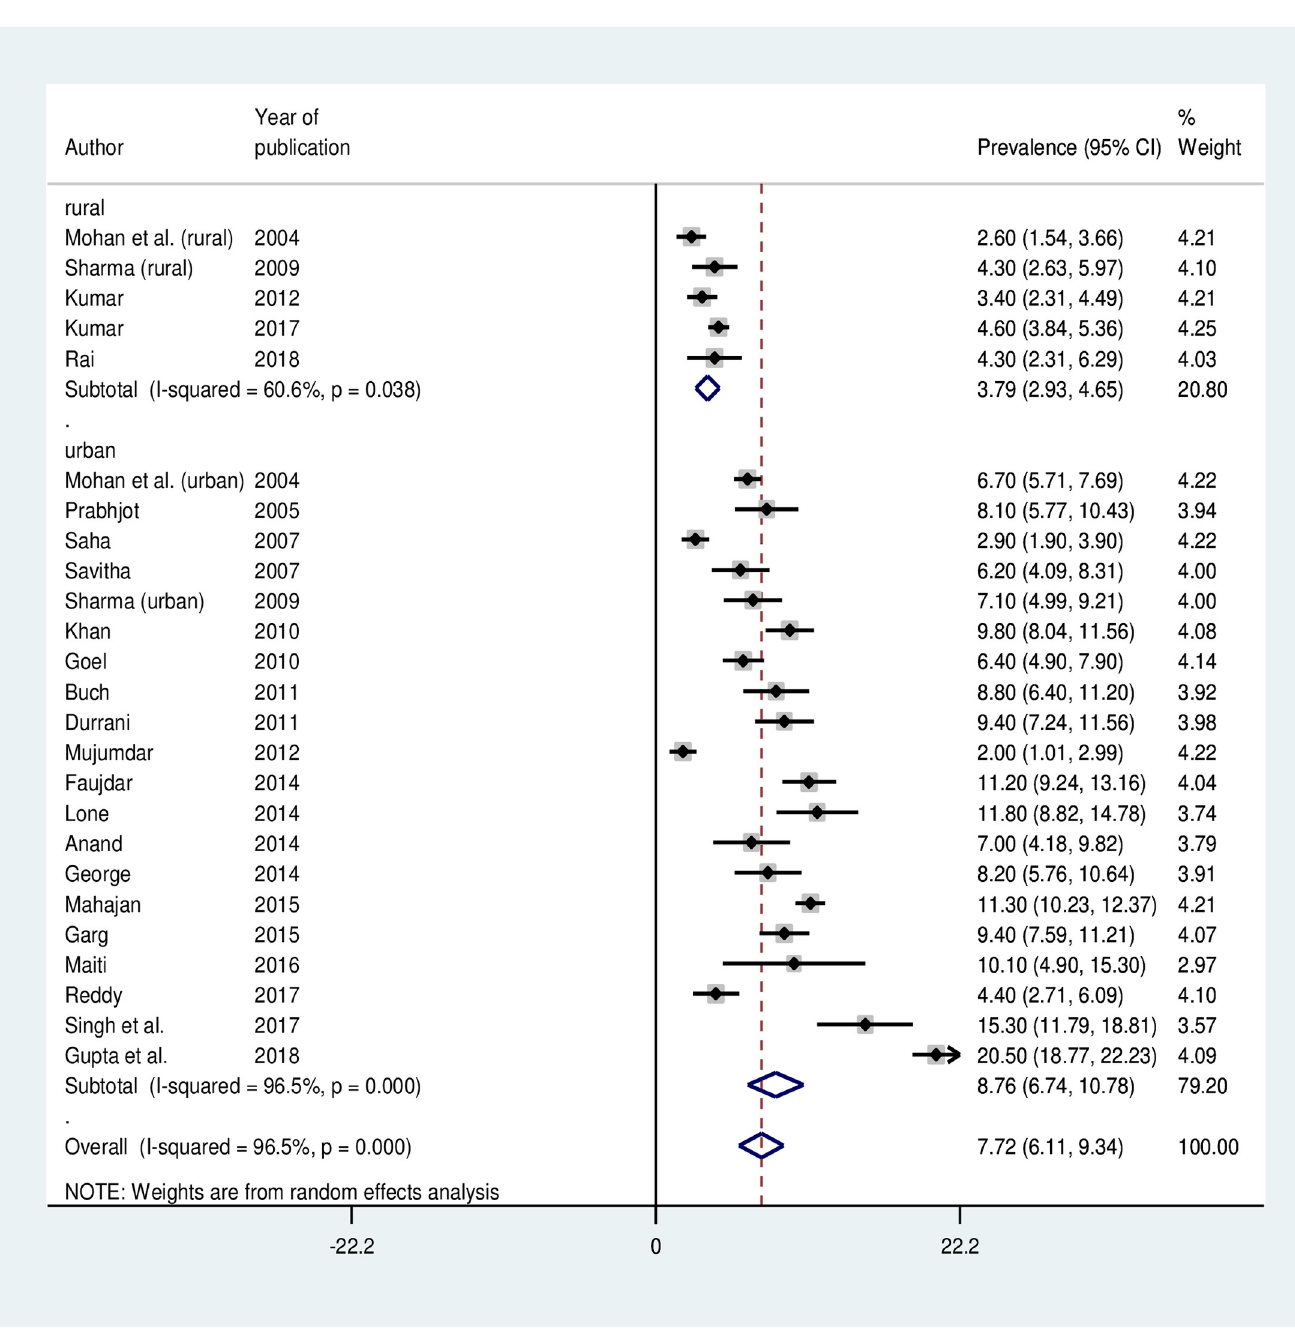
Fig 5. Forest plot of prevalence of hypertension among adolescents in India based on study setting.